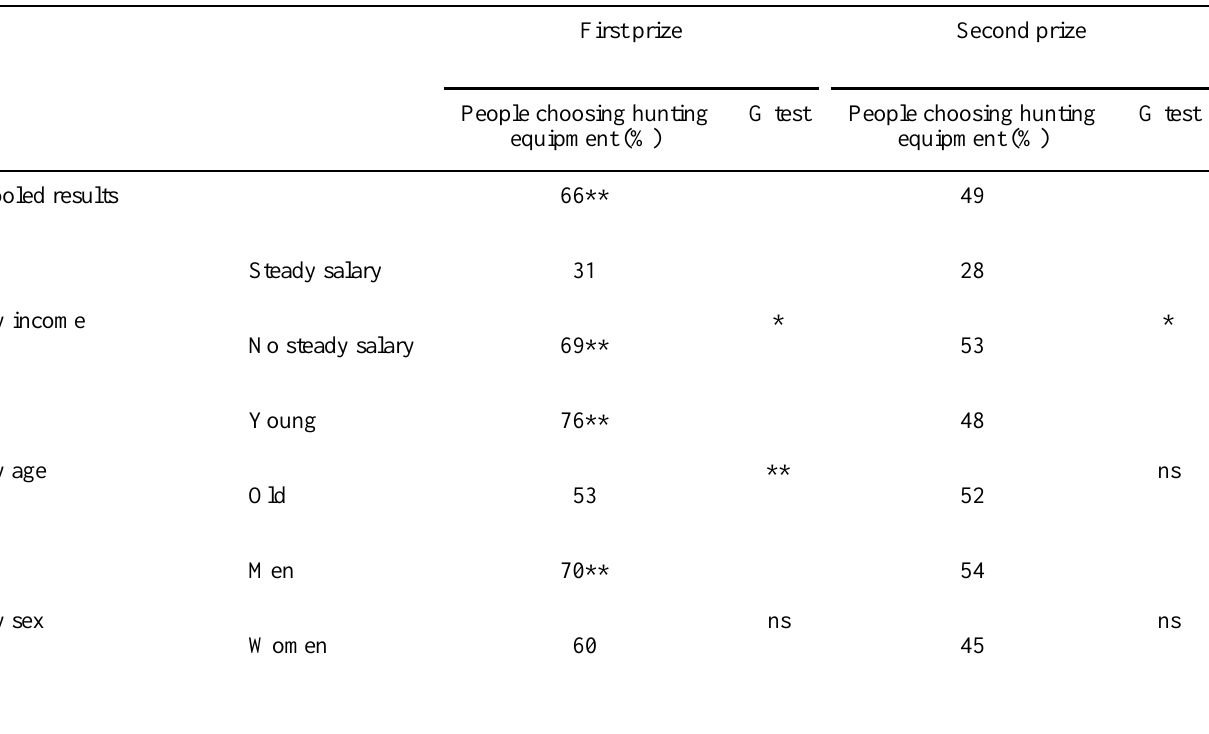
Table 1. Summary of experimental results and results of non-parametric statistical